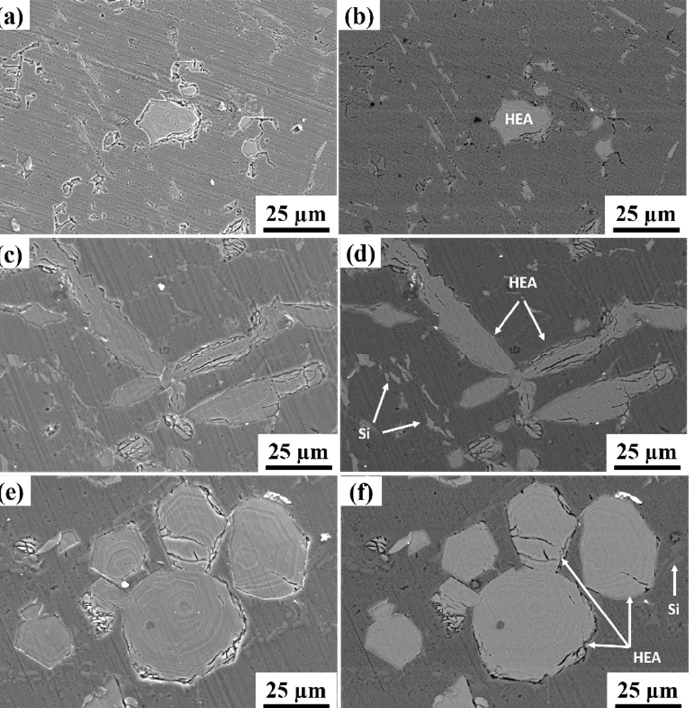
Figure 3. Scanning electron microscopy images of Al 6063–5 wt.% HEA in ( a ) secondary electron mode and ( b ) backscattered electron mode. Scanning electron microscopy images of LM25–5 wt.% HEA in ( c ) secondary electron mode and ( d ) backscattered electron modes. Scanning electron mi- croscopy images of LM25–10 wt.% HEA ( e ) secondary electron mode and ( f ) backscattered electron mode.